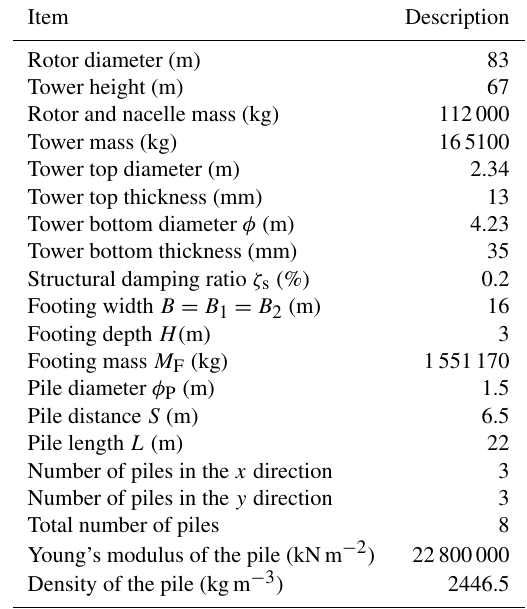
Table 2. The outline of the 2MW wind turbine and its support struc-